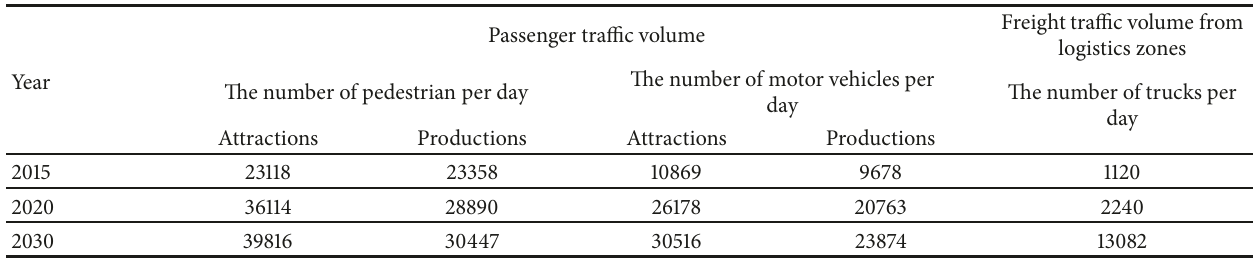
Table 2: Traffic volume from urban area and logistics zones for three representative years, 2015, 2020, and 2030.